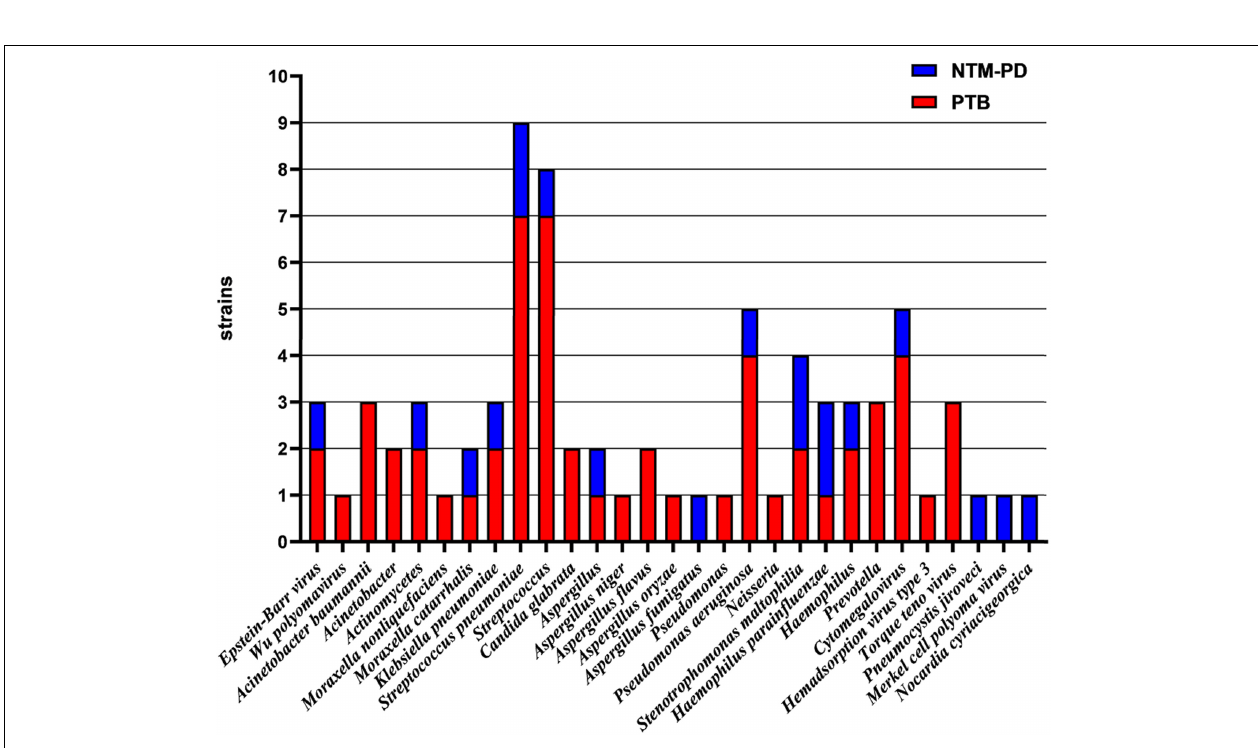
Frontiers in Microbiology |